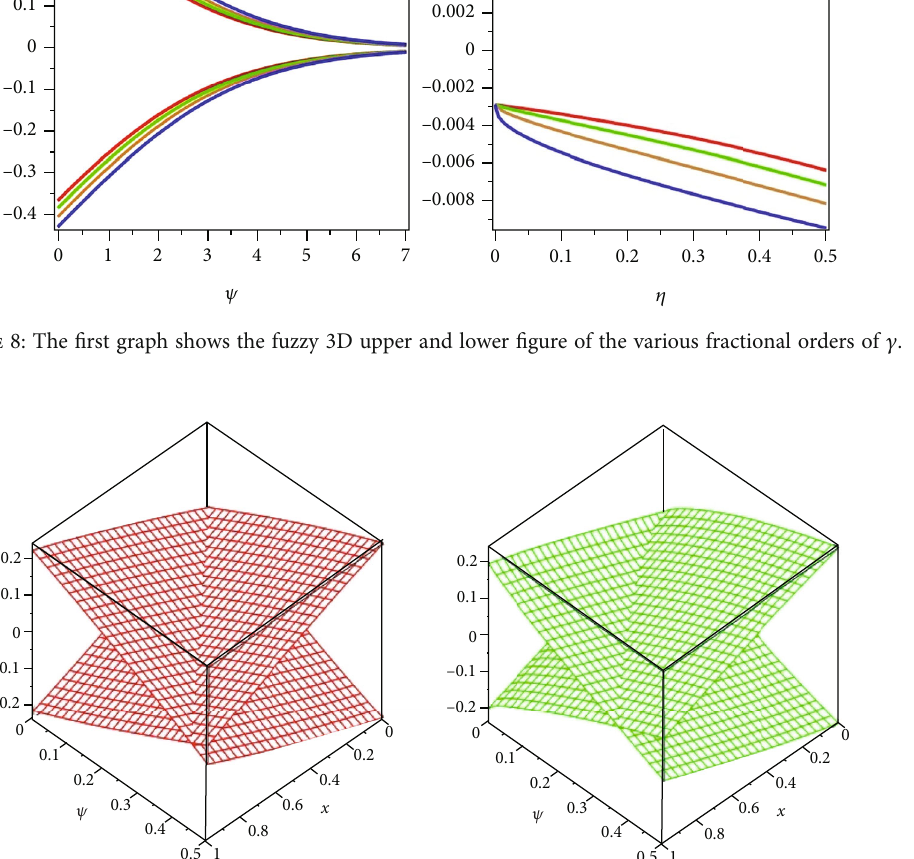
Figure 9: The fi rst graph shows the fuzzy 3D upper and lower fi gure of analytical solution at γ = 1 and the second graph at fractional of γ = 0 : 8 .